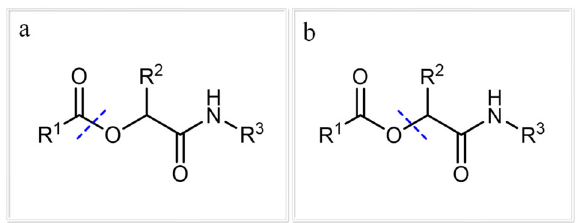
Fig. 4 Most common fragmentation patterns of the oligomer during fragmentation by tandem ESI-MS/MS 8 . a Fragmentation next to the carbonyl, which is preferred in measurements without any additives. b The fragmentation next to the ester group is preferred when sodium tri fl uoroacetate is used as